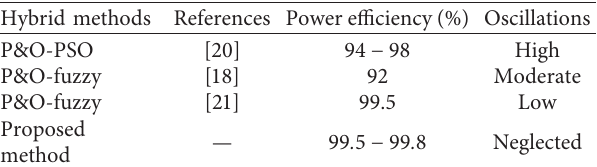
Table 6: Comparison between the P&O algorithm and other hybrid methods.